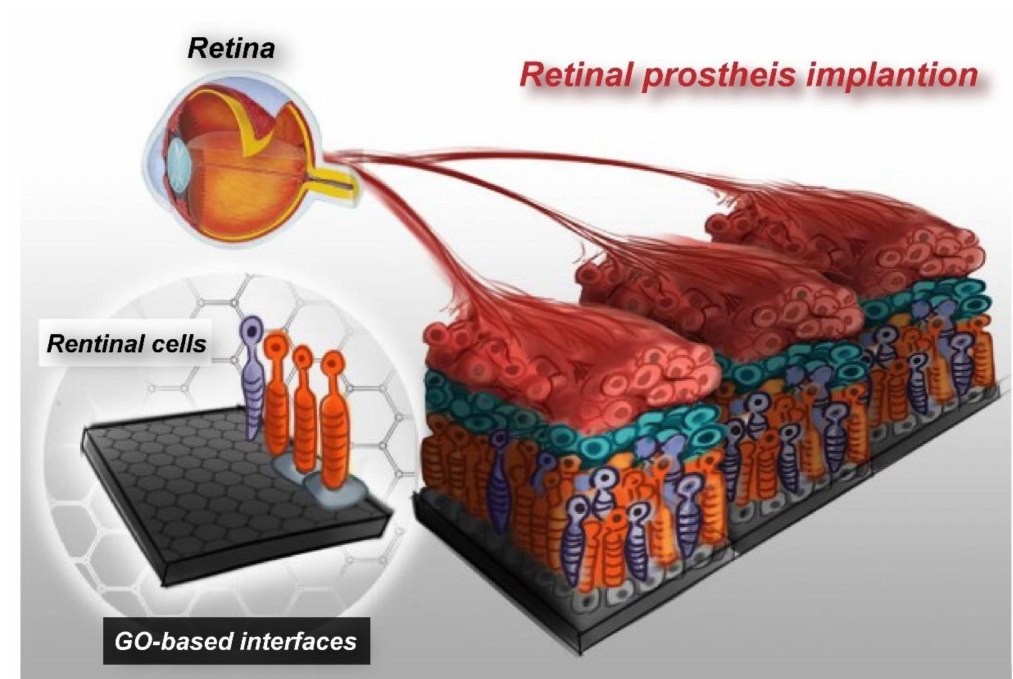
Figure 7. Concept of the advanced electronic retinal prosthesis. Establishing GO-based electrode interfaces with embedded retinal cells, which has the potential to improve the e ffi ciency of retinal prosthesis tissue regeneration and repair